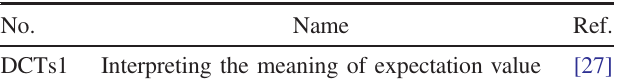
TABLE IX. Difficulties that exhibit all types of error in problems which require frame shifting. This difficulty is labeled “ DCT ” because it may involve all three types of error and s because the problem requires